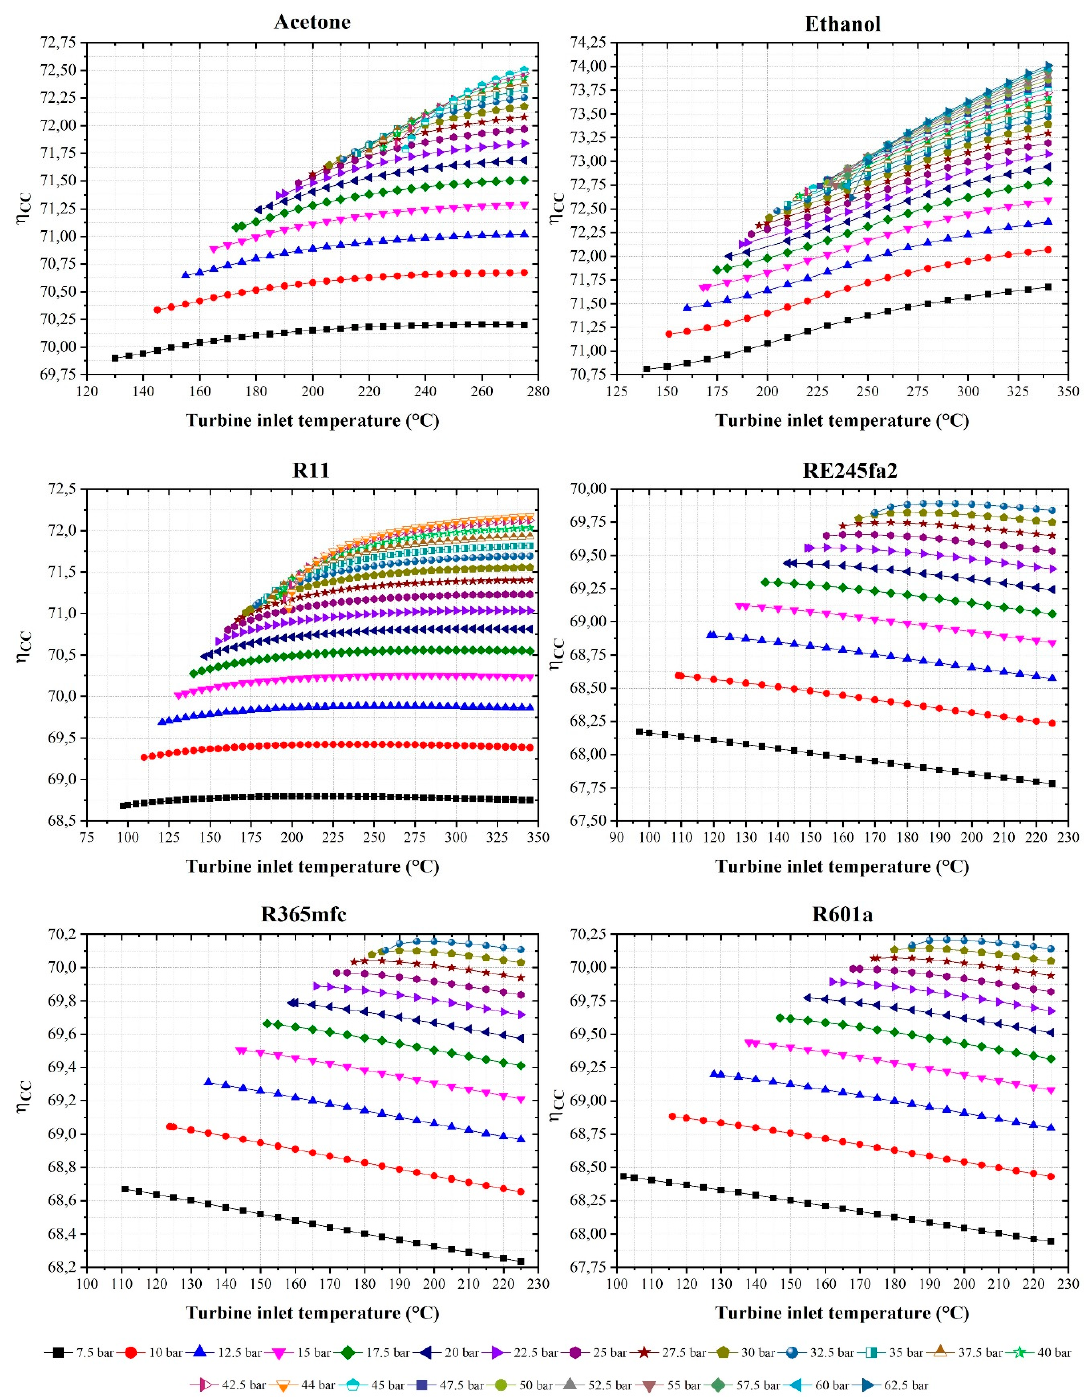
Figure 9. The change in the thermal efficiency of the cogeneration cycle by considering the selected organic working fluids, ORC-turbine inlet temperature and ORC-turbine inlet pressure.